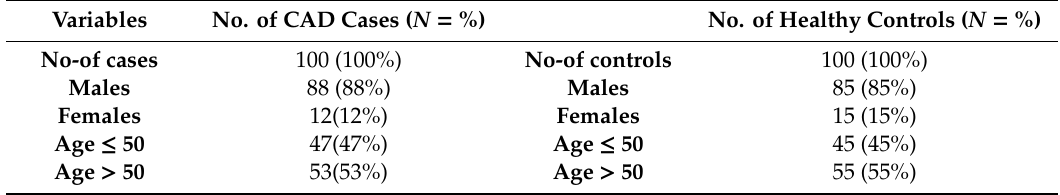
Table 2. Baseline characteristics of coronary artery disease (CAD) patients and controls.